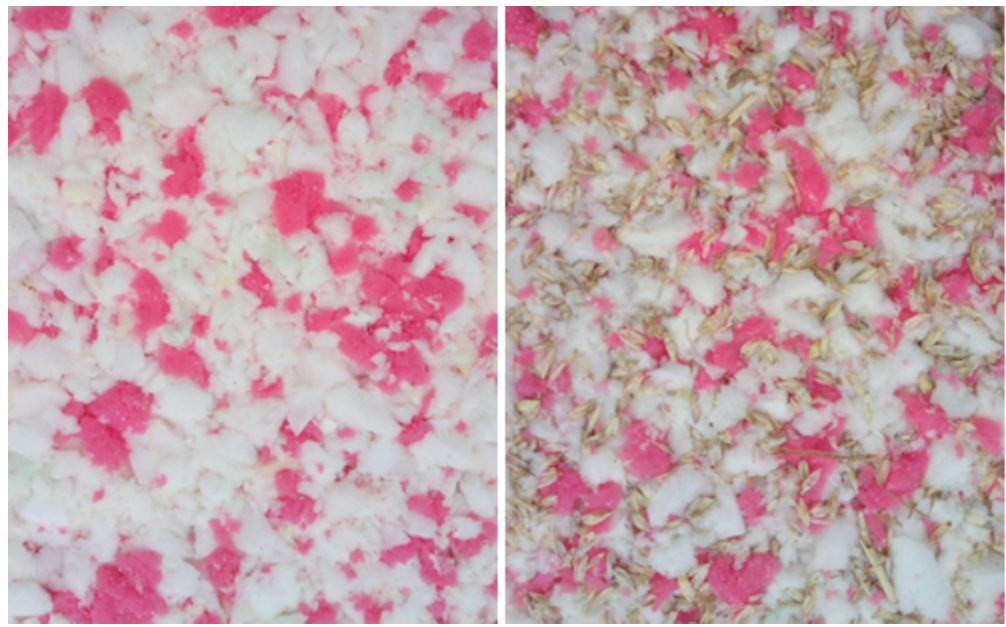
Figure 1. Surface view of the thermal insulation layer, board without husks on the left , board with addition of husks on the right .